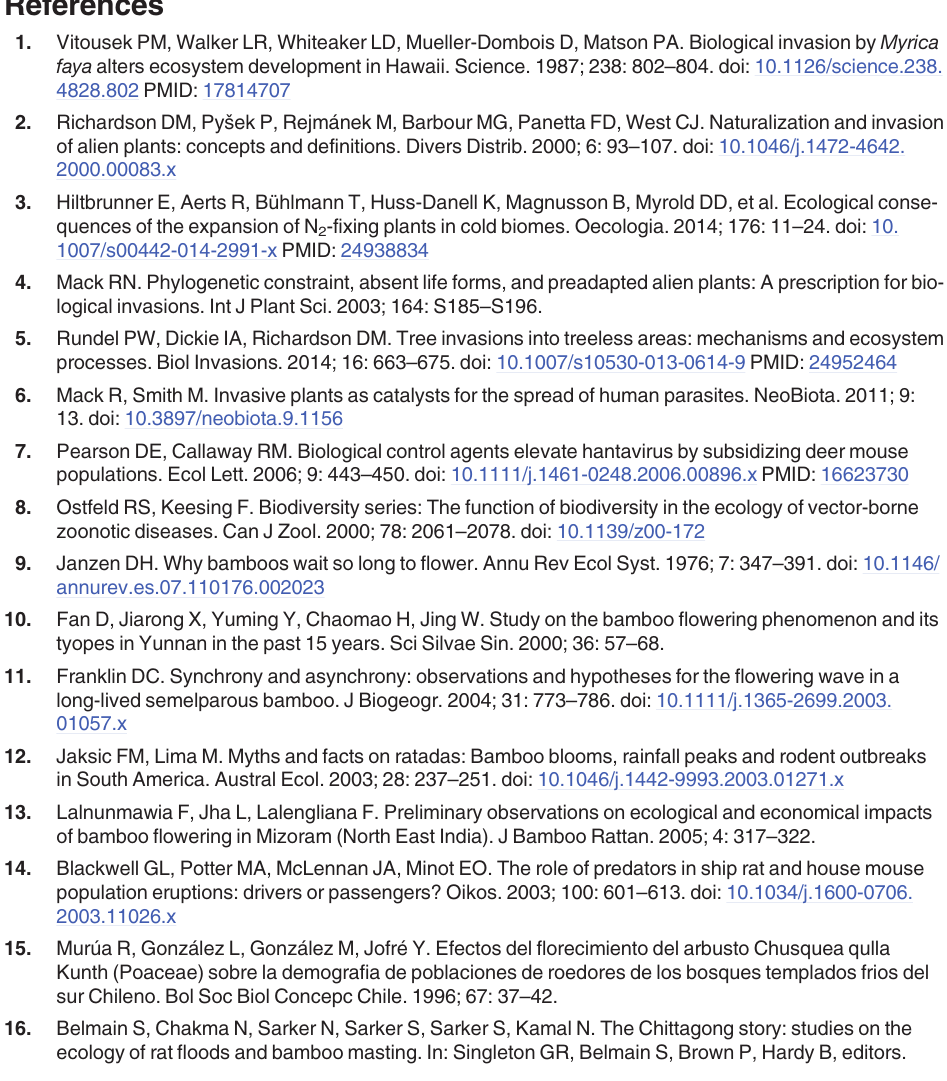
S3 Table. Caloric content of seeds used in our study. All measurements are an average (± SE) of three 5-g samples that were ground and combusted in an oxygen bomb